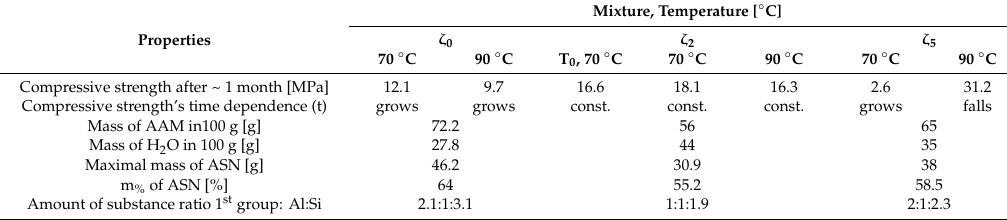
Table 5. Basic theoretically estimated parameters and measured mechanical properties of AAM synthesized using 50 g of mixtures ζ 0 , ζ 2 , and ζ 5 , cured first on room temperature (for 4 h) and then on 70 ◦ C (for 20 h), and for 24 h on 70 and 90 ◦